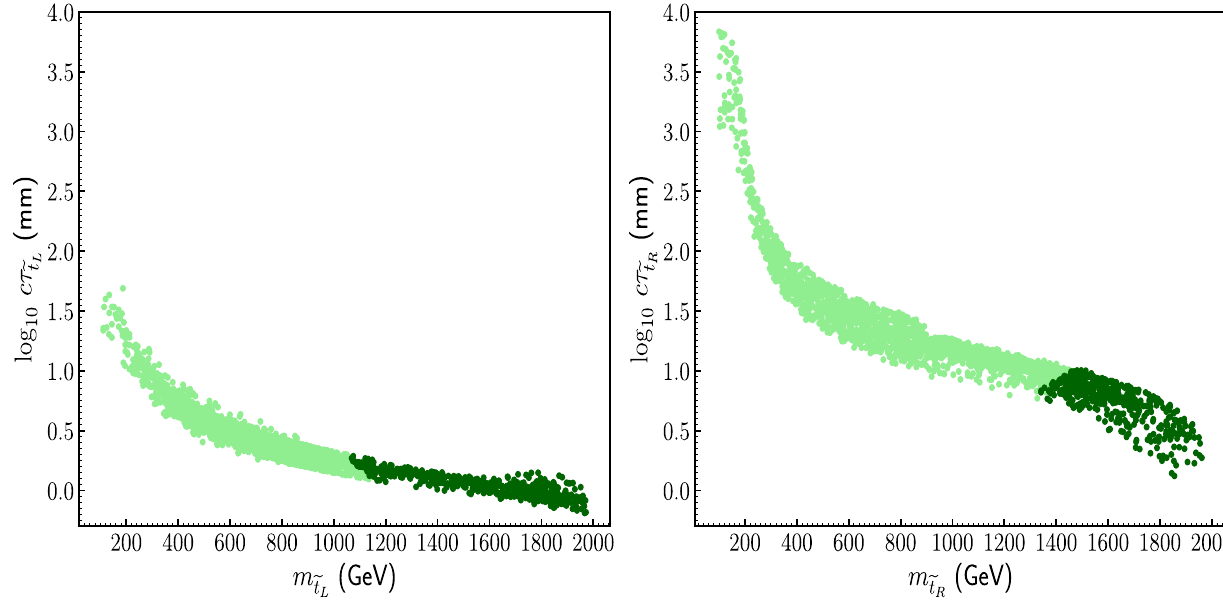
Fig. 4 Proper decay length c τ (cid:4) t versus the stop mass m (cid:4) t for (left plot) left stop LSP and (right plot) right stop LSP. All points fulfill the experimental constraints of Sect. 4.1. Light (dark)-green points do not fulfill (fulfill) the LHC constraints